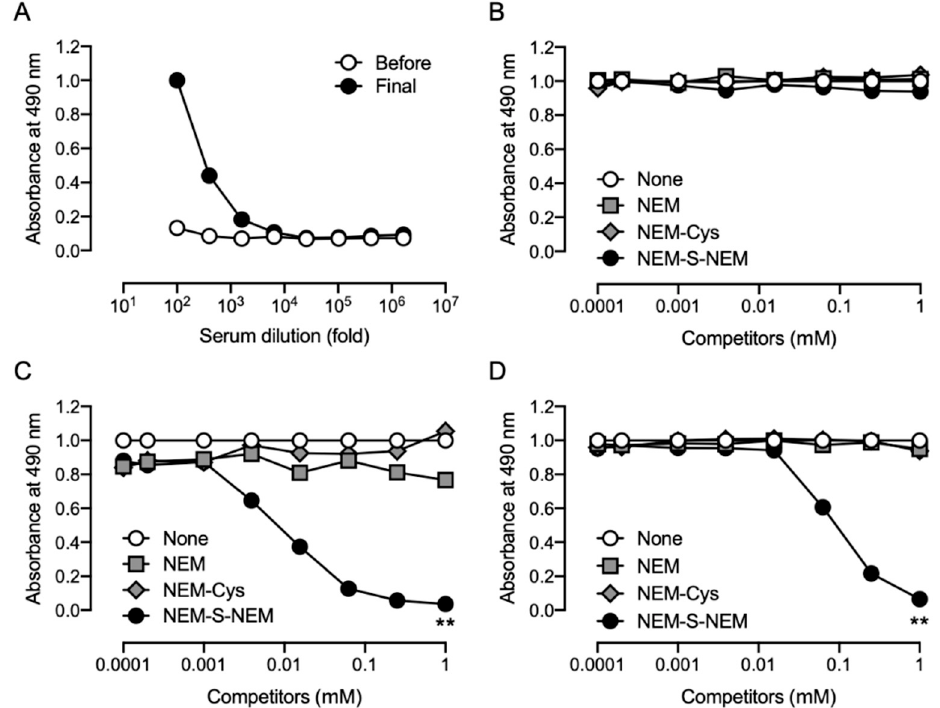
Figure 5. Characterization of rat monoclonal antibody. Wister rat was subcutaneously injected with NEM-S-MPA-conjugated BSA. The antibody titer in rat antiserum obtained from the immunized rat before the immunization ( before ) and 3 days after the last booster injection ( final ) was measured by ELISA with NEM-S-MPA-conjugated OVA as an antigen ( A ). Antibody specificity of the rat antiserum ( B ) and two monoclonal antibodies (mAb) produced by stable hybridoma cell lines (1C6 and 2D7) ( C , D ) was confirmed by competitive ELISA using NEM-S-NEM, NEM-Cys, and NEM as competitors. ** p < 0.0001 vs. none, compared by two-way ANOVA with Tukey’s multiple comparisons test.